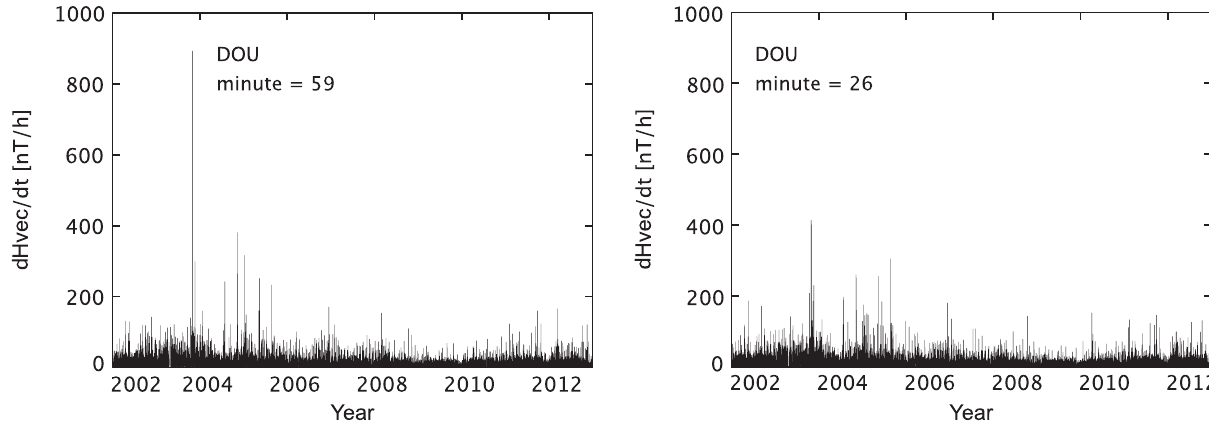
Fig. 10. All values of |d H /d t | at DOU in 2002–2012 for 1-h spot readings at minutes 59 (left) and 26 (right).